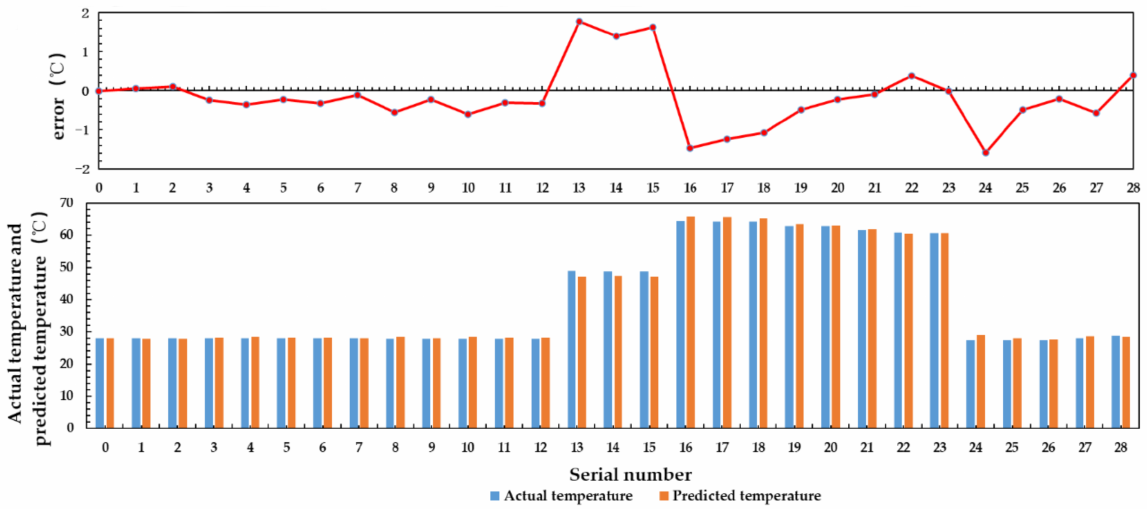
Figure 26. Inversion results of multiple linear regression. The BP neural network algorithm can be used in the water temperature inversion algorithm. BP neural network uses the steepest descent method to continuously adjust the weights and thresholds of the network through back propagation to minimize the sum of squares of the network errors. This process continues until the error of the network output is reduced to less than 0.1 ◦ C or the number of learning times set in advance has reached. The BP neural network model is shown in Figure 27.